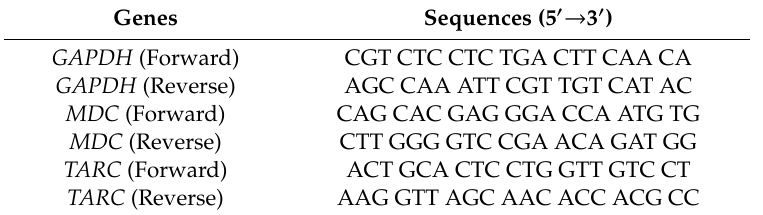
Table 1. Sequences of real-time reverse transcription polymerase chain reaction (RT-PCR) primers. Genes Sequences (5 (cid:48) → 3 (cid:48)